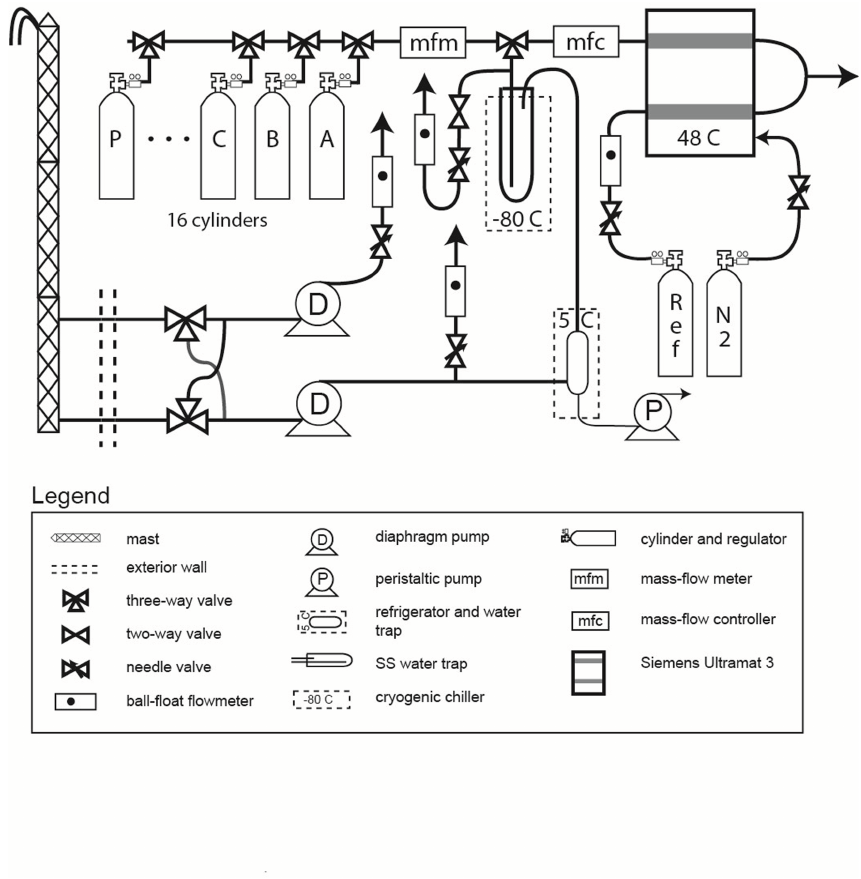
Fig. 2. Schematic of the Baring Head CO 2 system. Components include two alternating inlet lines, pumps, needle valves, a mass flow meter, a mass flow controller, a solenoid valve, fridge and cryogenic water traps, a Siemens Ultramat 3 CO 2 analyser, and reference gases for calibrating with respect to the WMO CO 2